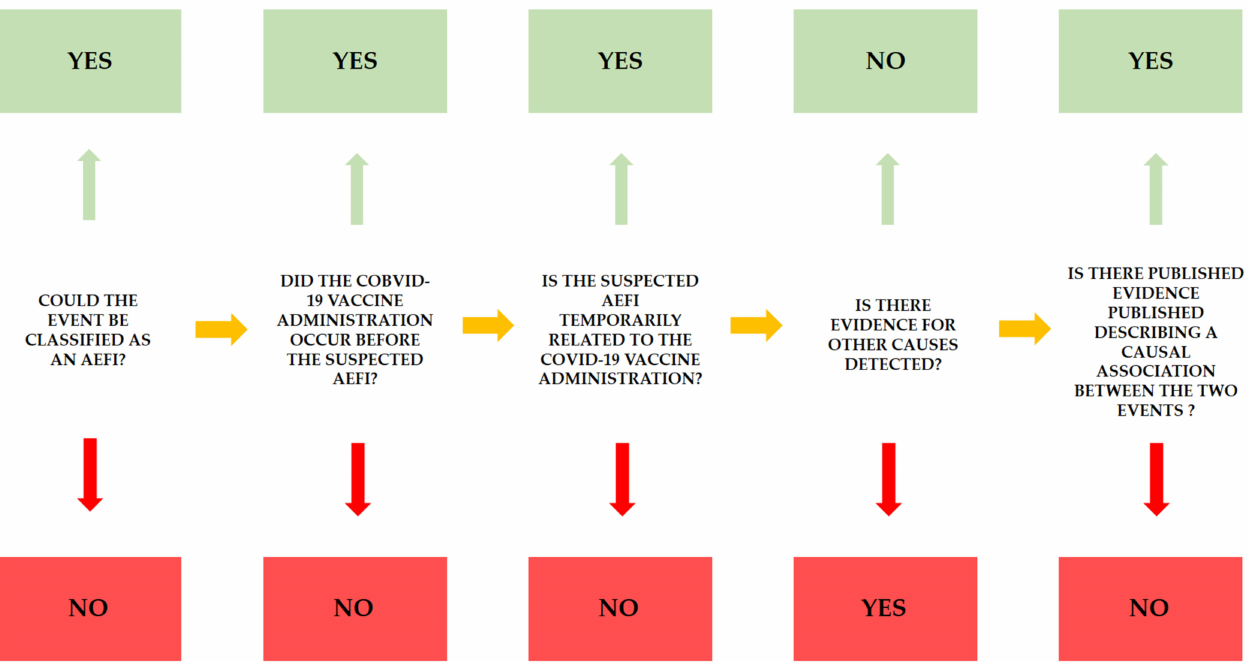
Figure 2. For each AEFI, this flowchart should be applied in order to define the causality assessment between the two events, vaccine administration and AEFI. The green answers reinforce the